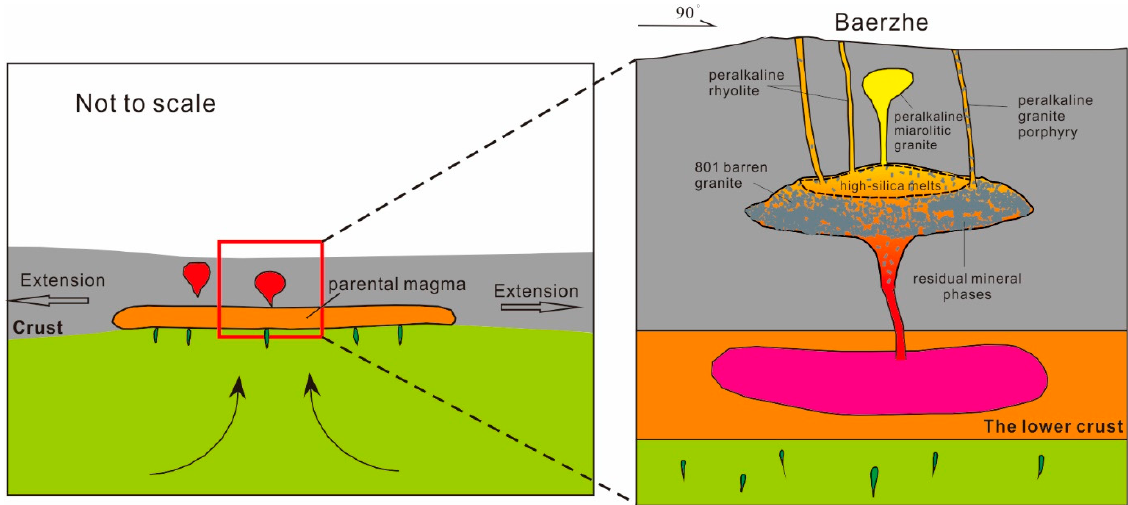
Figure 12. Cartoon illustrating the temporal evolution of plutonic–subvolcanic connections for peralkaline granitic dikes and Baerzhe granites. See the text for a detailed explanation of the mod-